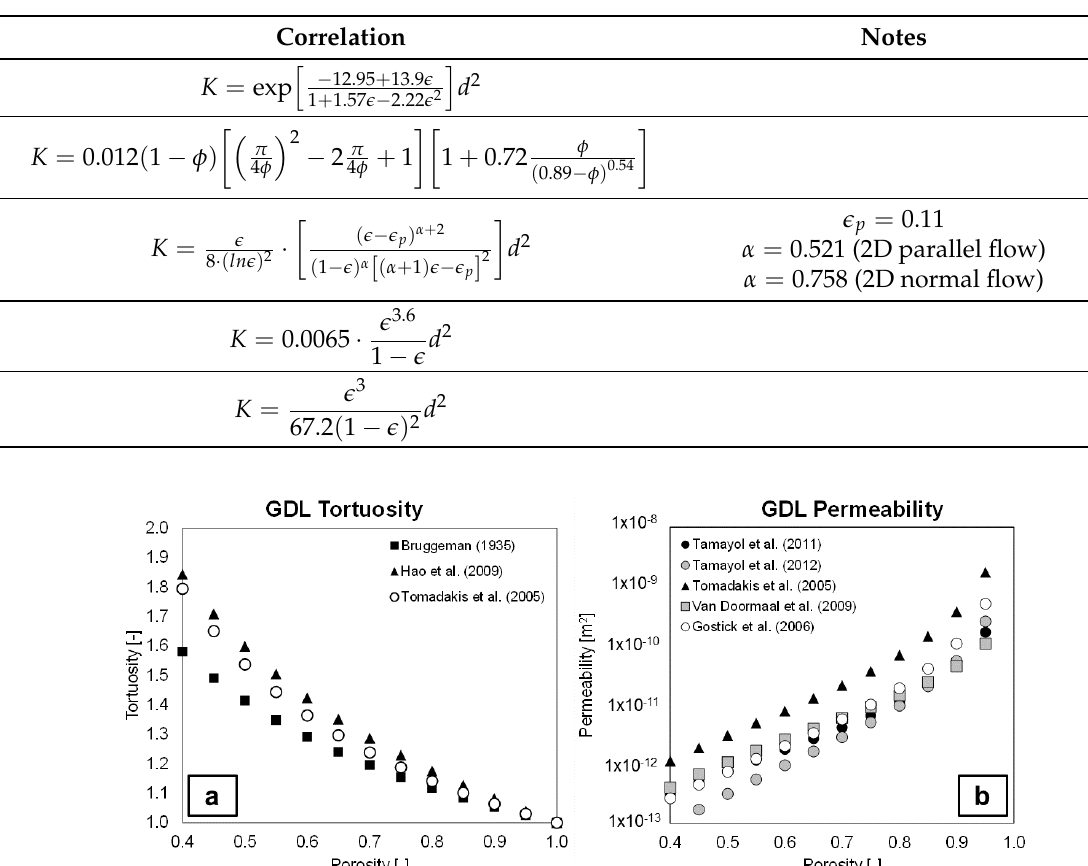
Table 6. Correlations for GDL permeability K [m 2 ].